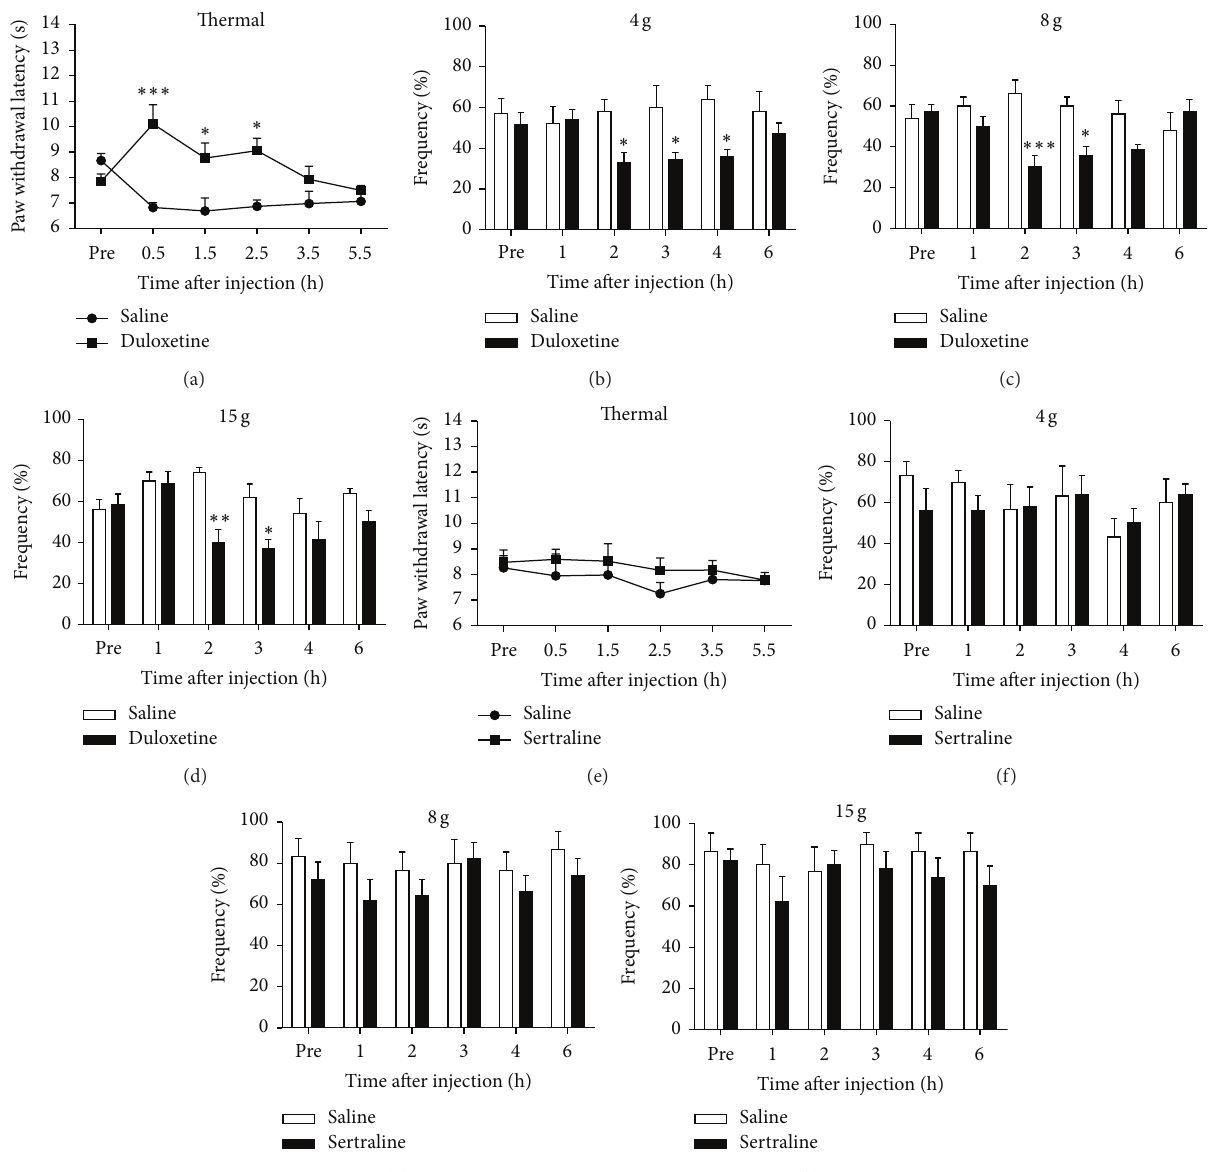
Figure 7: Effects of duloxetine and sertraline on thermal and mechanical hypersensitivity in 6-OHDA-lesioned rats. Rats were i.p. injected with 10mg/kg duloxetine or equal volume of 10% dimethylsulfoxide on the 5th week after 6-OHDA microinjection. ((a)–(d)) Systemic application of duloxetine significantly inhibited thermal (a) and mechanical hypersensitivity ((b)–(d)) in the 6-OHDA-lesioned rats ( ∗ 𝑃 < 0.05 , ∗∗ 𝑃 < 0.01 , and ∗∗∗ 𝑃 < 0.001 for duloxetine compared to the vehicle control, 𝑛 = 5–7 for each group). ((e)–(h)) Systemic application of sertraline (10mg/kg, i.p.) did not significantly affect thermal (e) and mechanical hypersensitivity ((f)–(h)) in the 6-OHDA-lesioned rats ( 𝑃 > 0.05 , 𝑛 = 5 for each